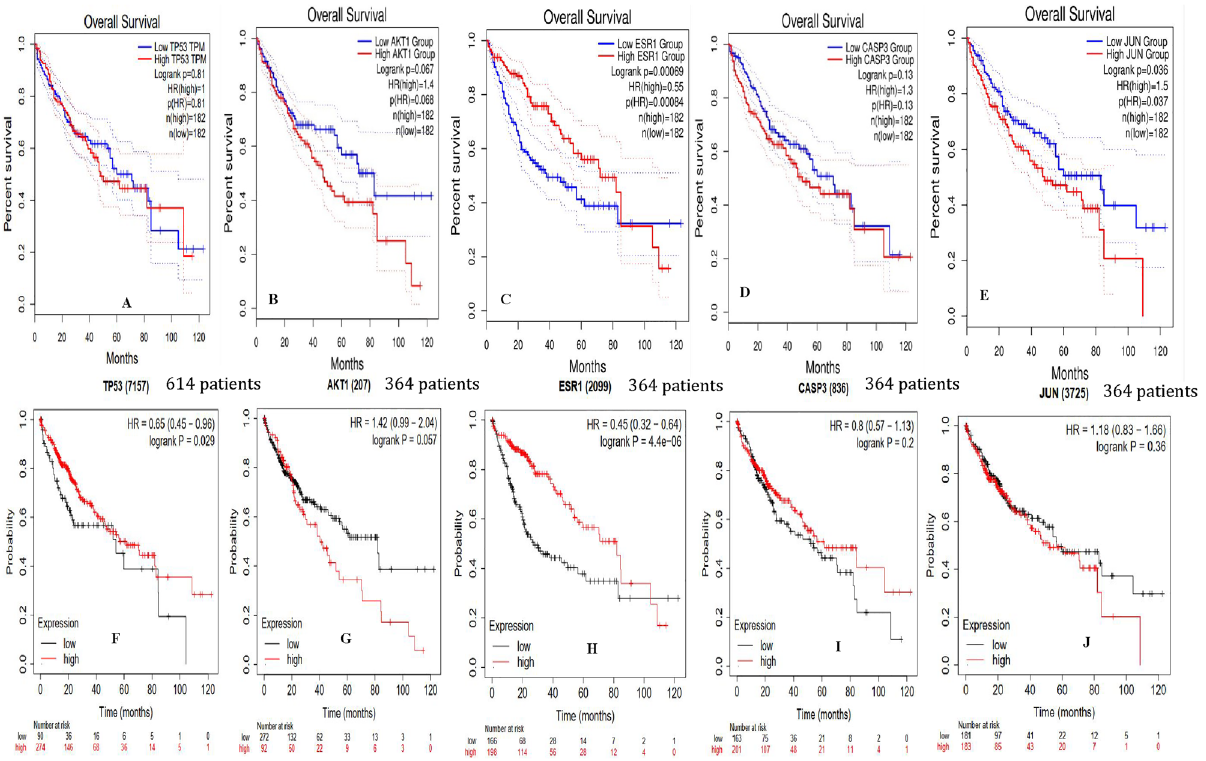
Figure 4. The overall survival of patients ( A–E ) and ( F–J ) with HCC by Kaplan–Meier plots (https:// kmplot. com/ analy sis).